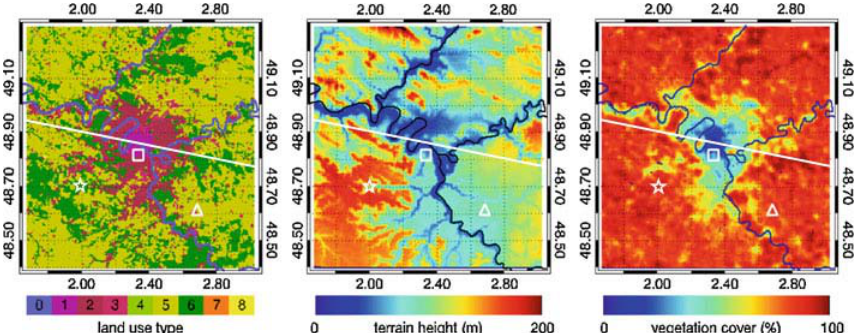
Fig. 1. Land-use types (left), terrain height (middle) and vegetation cover (right) of the Paris 1km simulation domain. The different land-use types are defined as water (0), urban (1), sub-urban (2), industrial (3), grass(4), crops (5), forest (6), snow/ice (7), shrubs (8). The rectangular and the triangular box represent the locations of the urban (Paris-Montsouris, square) and rural (Melun, triangle) stations, respectively. The star indicates the location of the radio soundings at Trappes. The line indicates the vertical transect along the prevailing east wind in the base run used for the vertical profile